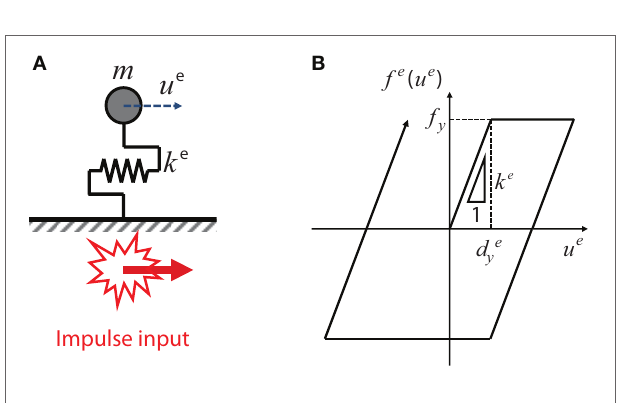
FigUre 6 | equivalent sDOF model of simplified swaying-rocking model: (a) model parameters and (B) restoring force characteristic.